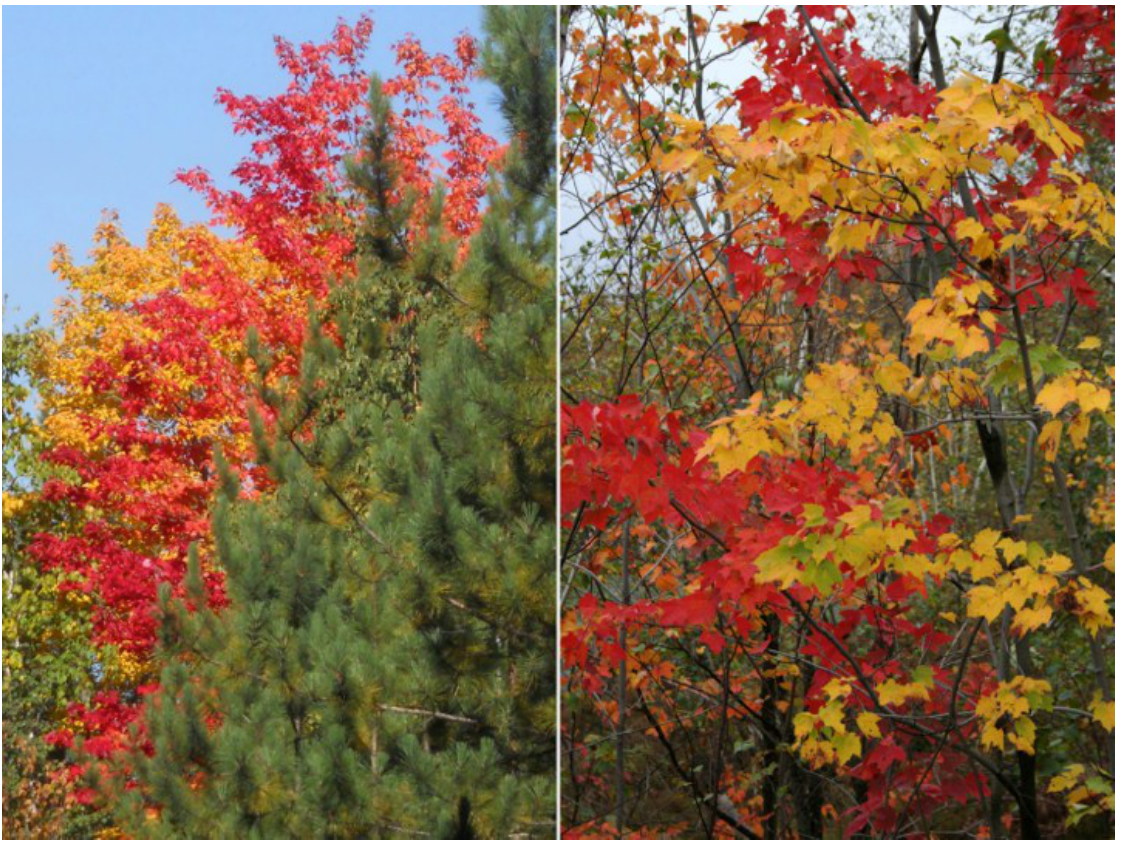
Figure 2. Acer rubrum trees vary in the degree of anthocyanin accumulation in their leaves during autumn senescence, even among trees with a similar exposure to light. Pictures taken in Sudbury, Ontario, Canada on 25 September 2014 ( left ), and 8 October 2007 ( right